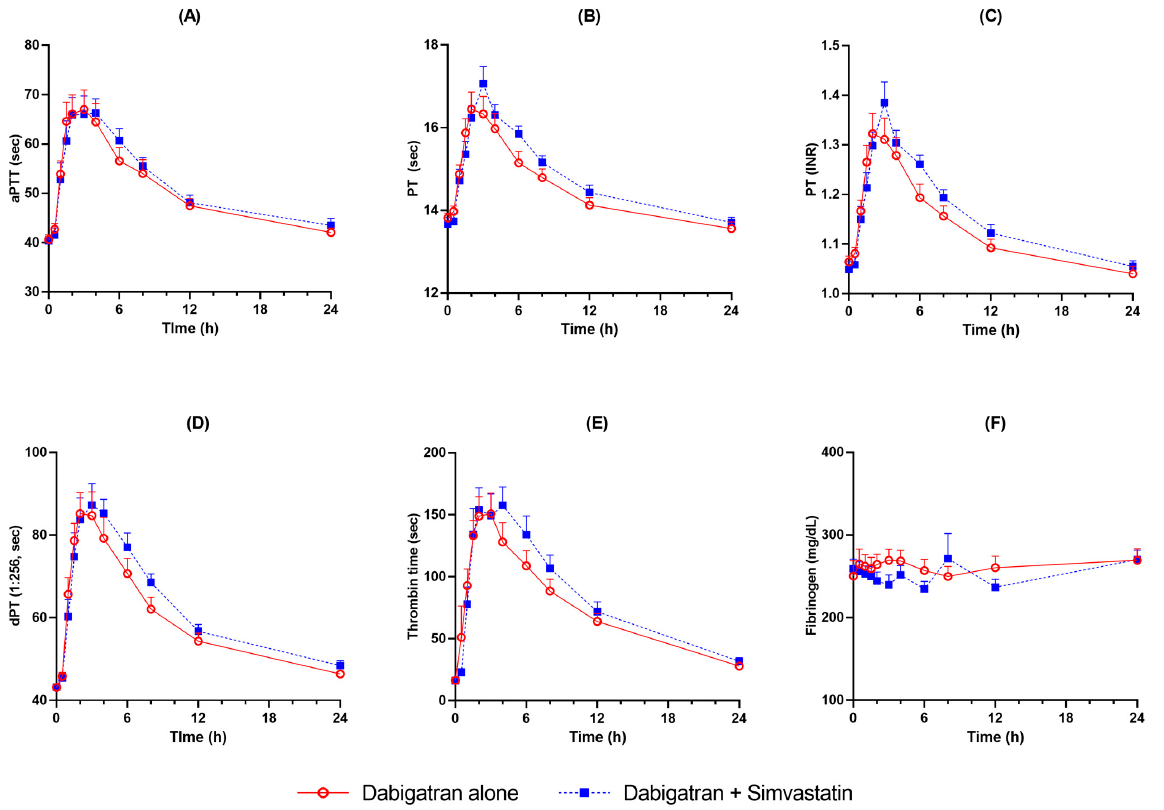
Figure 2. Coagulation assay profiles after administration of dabigatran etexilate alone and co-administration with simvastatin (activated partial prothrombin time (aPTT, ( A )), prothrombin time (PT (s), ( B )), prothrombin time (PT (INR), ( C )), diluted PT (dPT, ( D )), thrombin time ( E ), and fibrinogen ( F )). Table 3. Pharmacodynamic parameters of dabigatran before and after co-administration of simvastatin. Parameter Dabigatran Alone Dabigatran with Simvastatin p